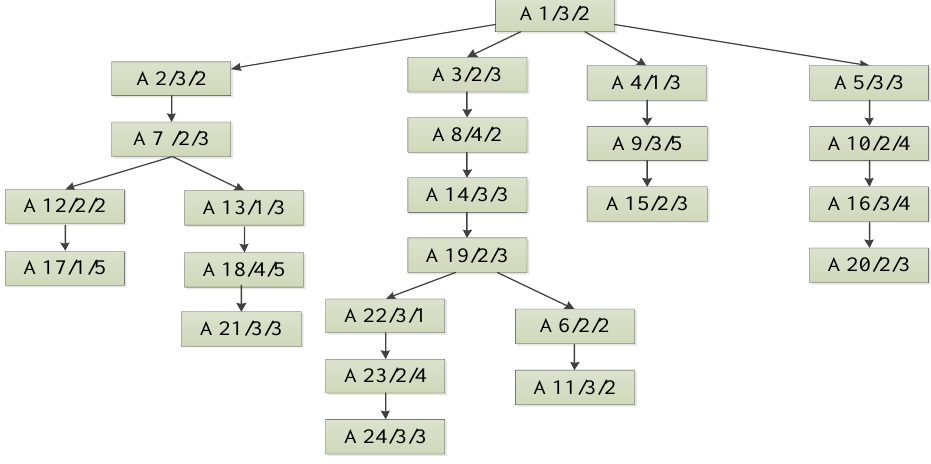
Figure 1. Product A processing process tree.